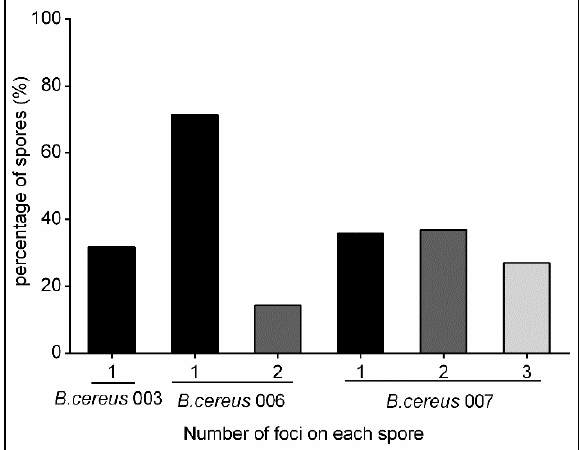
Figure 4. Percentage of germinosomes in dormant spores of B. cereus 003, B. cereus 006 and B. cereus 007. The germinosome in individual B. cereus 003 spores carrying pHT315-P gerR - gerRB - SGFP2 , B. cereus 006 spores carrying pHT315-P gerR - gerR - SGFP2 and B. cereus 007 spores carrying pHT315-P gerD - gerD - mScarlet-I were distinguished from the background fluorescence during the calculation process.